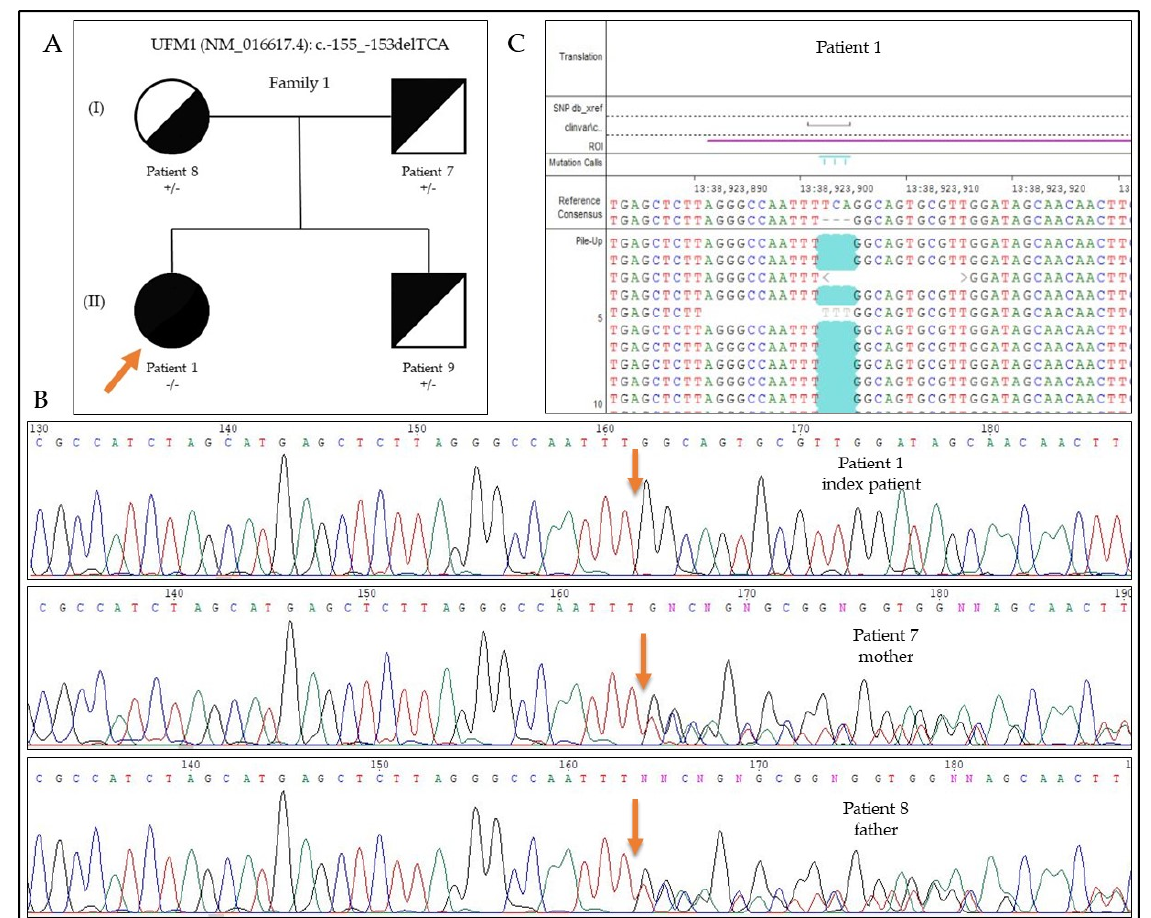
Figure 3. Pedigree and sequencing results of Family 1. ( A ) Family tree of Family 1. ( B ) Sanger sequencing of Patients 1, 7, and 8. Patient 1 is homozygous; Patients 7 and 8 are heterozygous for the UFM1 : c.-155_-153delTCA mutation. ( C ) Next-generation sequencing results of Patient 1, showing the homozygous deletion.